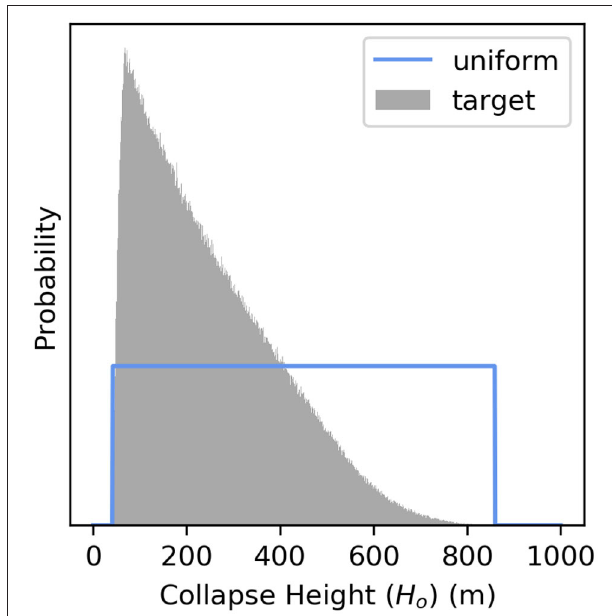
FIGURE 6 | Normalized histogram (gray) showing the expected “target” distribution of collapse heights ( H o ) above the vent, based on iterative evaluation of Equation (2) assuming the estimated distribution of vent radii and magmatic water contents at Aluto. A uniform PDF (blue) is fitted to this data and was used for sampling the H 0 parameter during energy cone simulation. In importance sampling, the histogram is used as a target PDF to weight the simulation